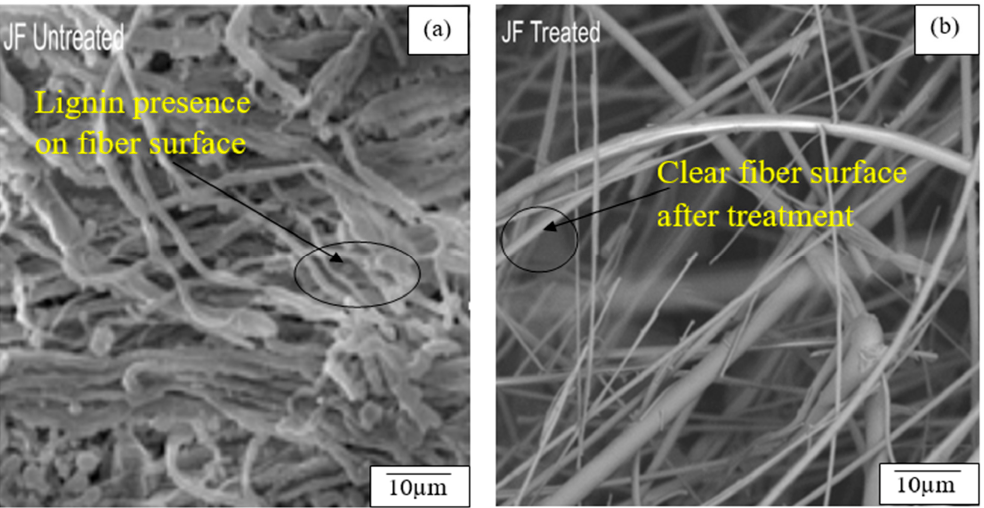
Figure 3. SEM Image of ( a ) Untreated Jute Fiber ( b ) Treated Jute Fiber.